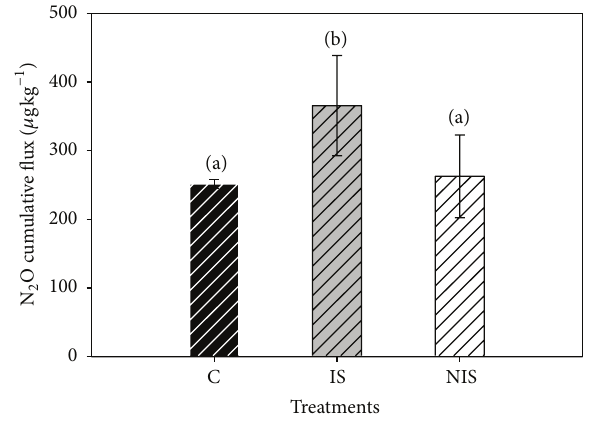
Figure 4: Cumulative N 2 O flux ( 𝜇 gkg −1 ) of different treatments. Means of 3 replicates per treatment with standard error. Different lower case letters indicate a statistically significant difference at 𝛼 =